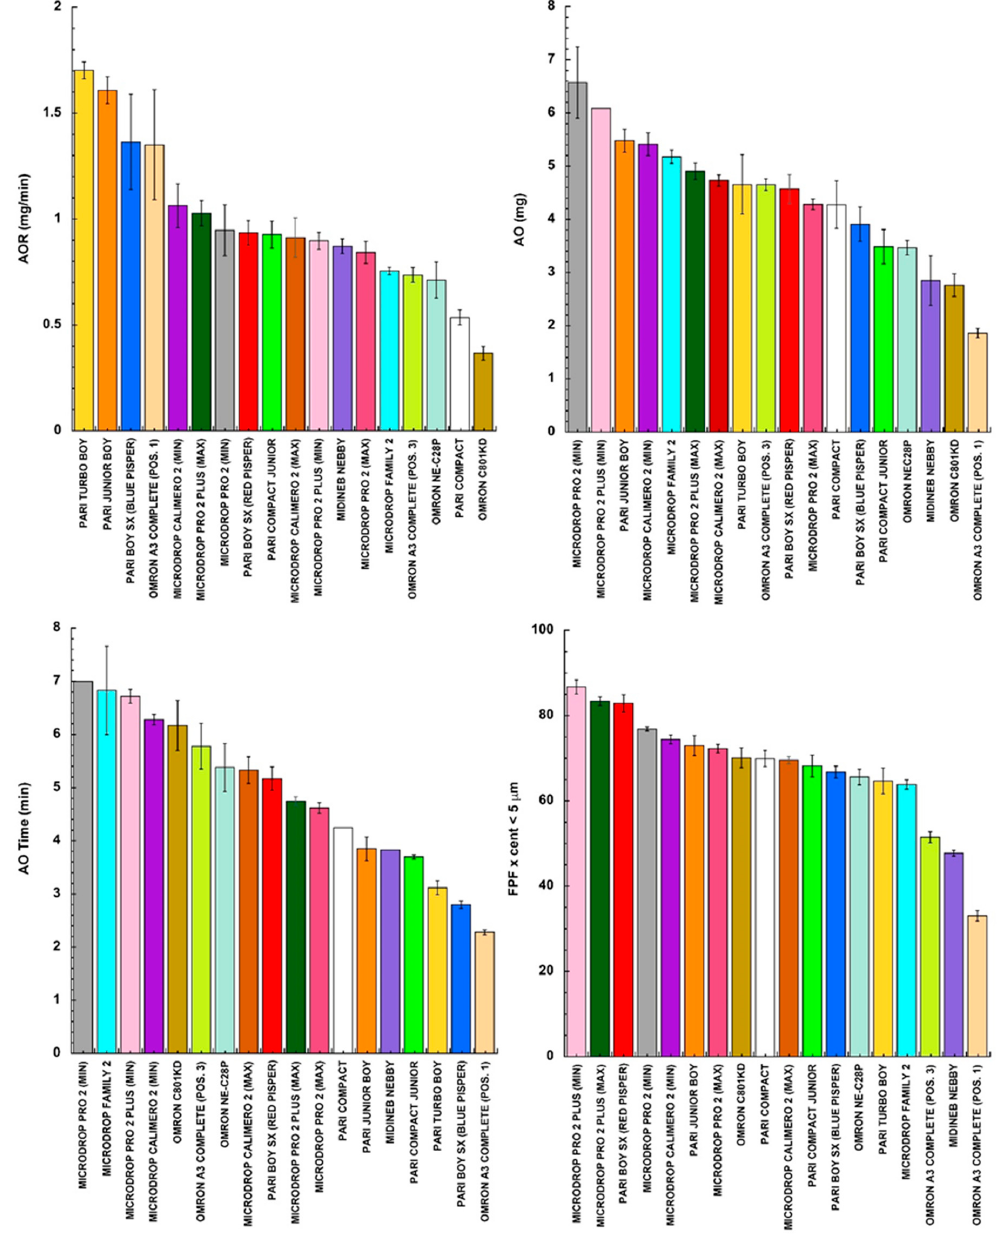
Figure 1. Aerosol output rate (AOR), aerosol output (AO), aerosolization time (AO time), and fine particle fraction (FPF) when 2 mL of NaF solution was aerosolized with the selected nebulizers from different manufacturers (mean value ± standard deviation, n = 3).